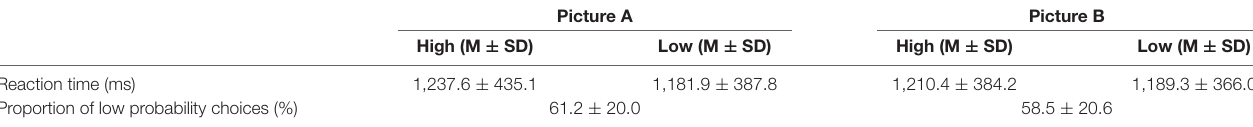
TABLE 3 | Proportion of low probability choices and reaction time as functions of probability (high vs. low) and contextual information (picture A vs. picture B).